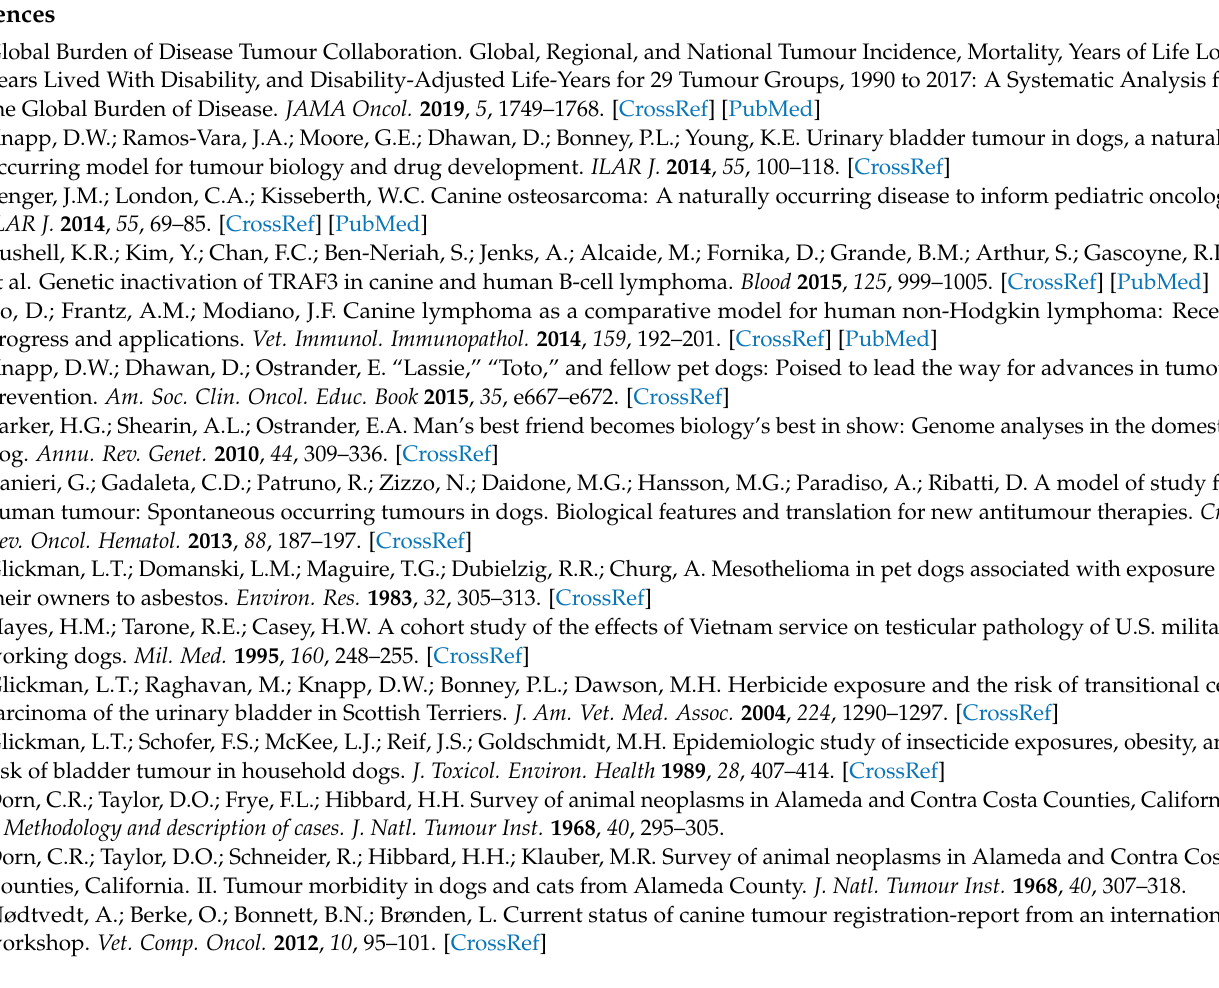
Figure A7. Proportional morbidity (PM) (solid lines) and their 95% confidence interval (dotted lines) of visceral benign tumours by period and macroregions.